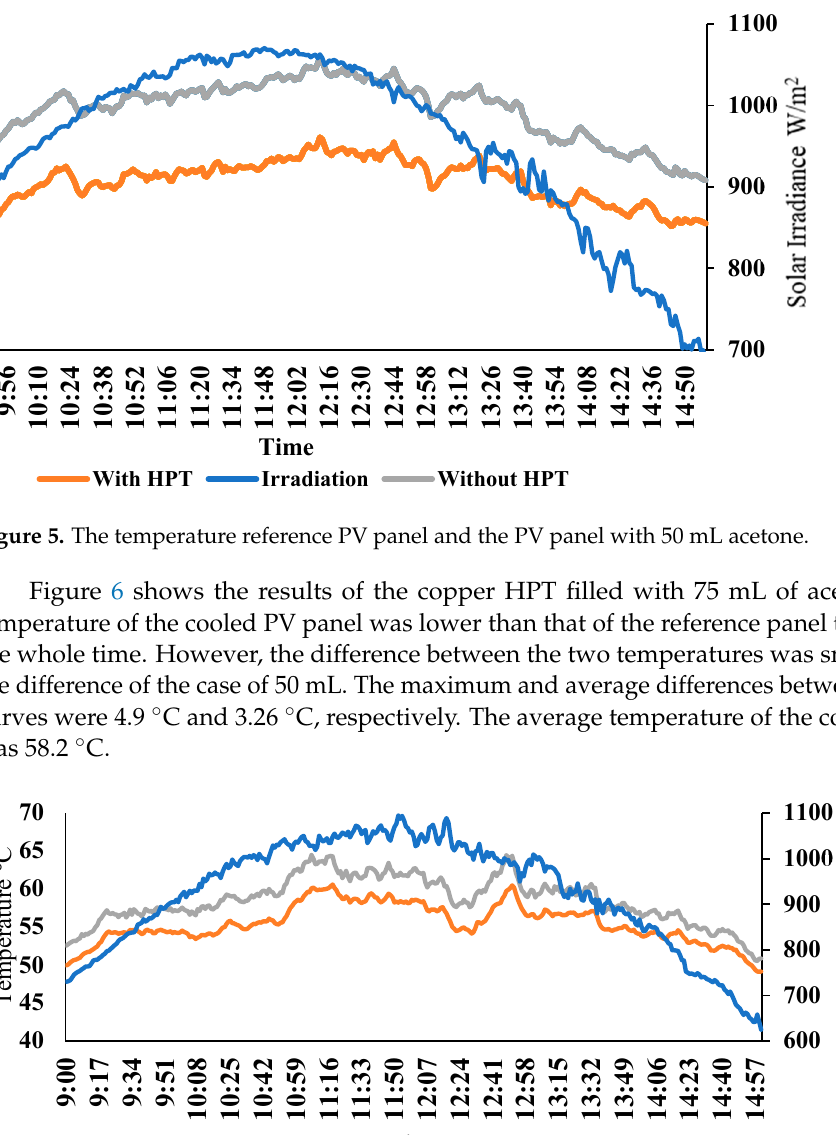
Figure 4. The temperature reference PV panel and the PV panel with 25 mL acetone.